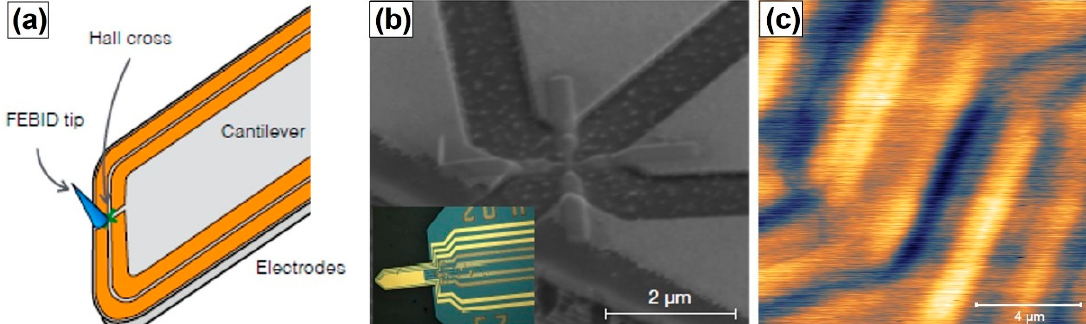
Figure 10. ( a ) Sketch of the self-sensing cantilever composed by the FEBID granular ferromagnetic Hall sensor cross surrounded by the Cr/Au electrodes. The non-magnetic FEBID tip was fabricated by Pt-C and is used for topographic information as an AFM tip. ( b ) SEM image of the granular ferromagnet Hall cross with the optical microscope image of the cantilever in the inset. ( c ) Scanning Hall probe microscopy image acquired with the granular ferromagnetic Hall sensor at 70 µA as the AC reference current. Adapted from [73].